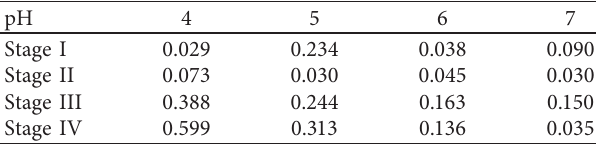
Table 9: W value in different situations.